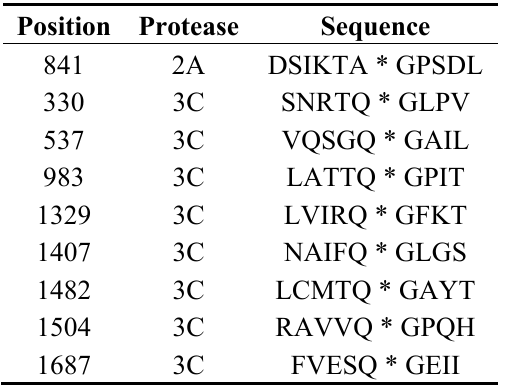
Figure 1. Predicted RNA structures of ( A ) the complete 5' UTR; ( B ) ribosomal entry structure within the IRES; ( C ) cis acting regulatory element in the VP2/VP4 gene. Table 1. 2A and 3C protease cleavage sites